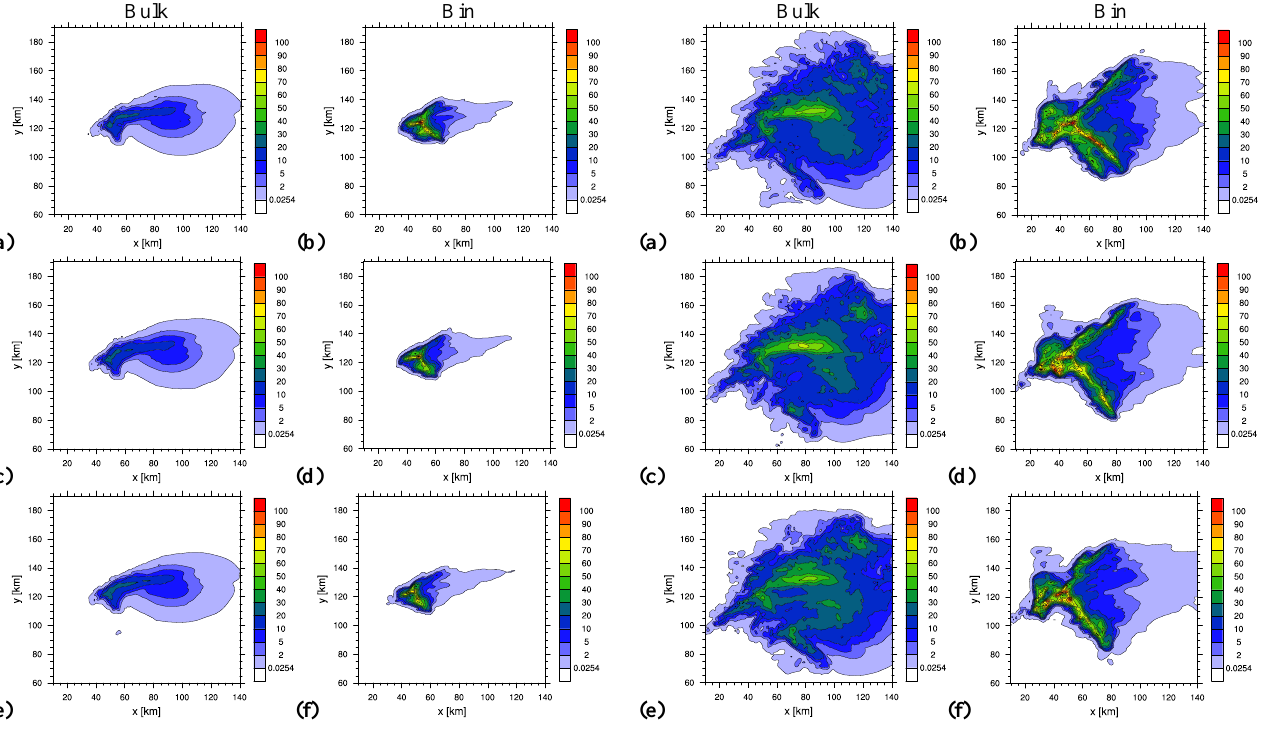
Fig. 4. Cumulative precipitation after 2h of simulation time for the ( a and b ) “Clean”, ( c and d ) “Semi-Polluted”, and ( e and f ) “Polluted” scenarios for high RH. Simulations performed with bulk microphysics are shown in (a, c, and e) and those with bin micro- physics in (b, d, and f) . Note that the x - and y -axes represent the grid location index and that the portrayed region is a subset of the entire domain, chosen to elicit the largest differences amongst the set of simulations performed. The first contour level is chosen to be 0.0254mm, which corresponds to 0.01 in. Any rainfall below this amount is considered to be a trace amount. Consequently, areas shown in white represent regions in which a trace or less of precip- itation as fallen.